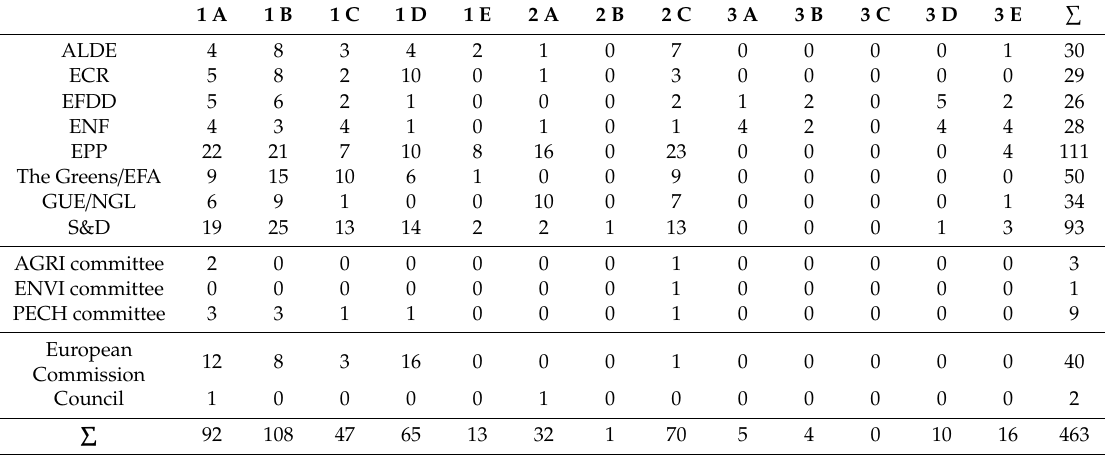
Table A2. Results of the qualitative content analysis: Number of coding units per sub-category and parliamentary group / committee / European Commission /